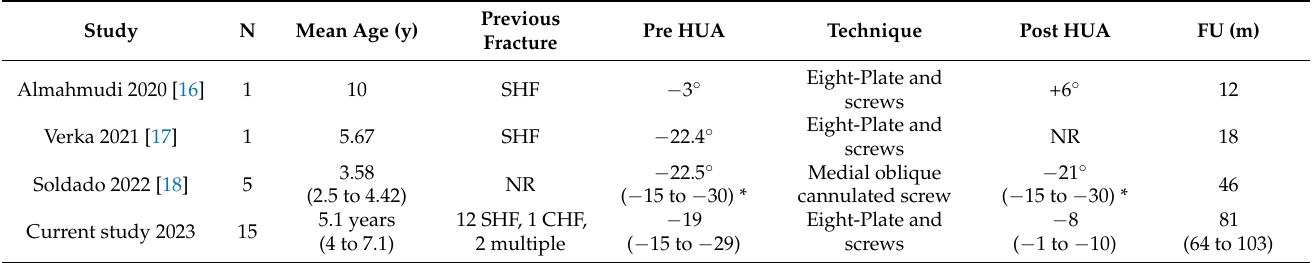
Table 3. Summary of published articles on lateral distal humerus